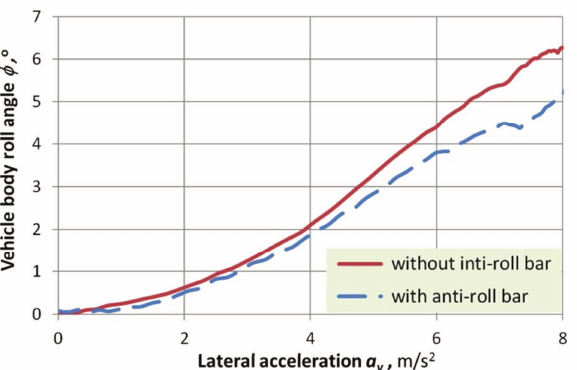
Fig. 15. The influence of anti-roll bars on the vehicle body roll angle. [own